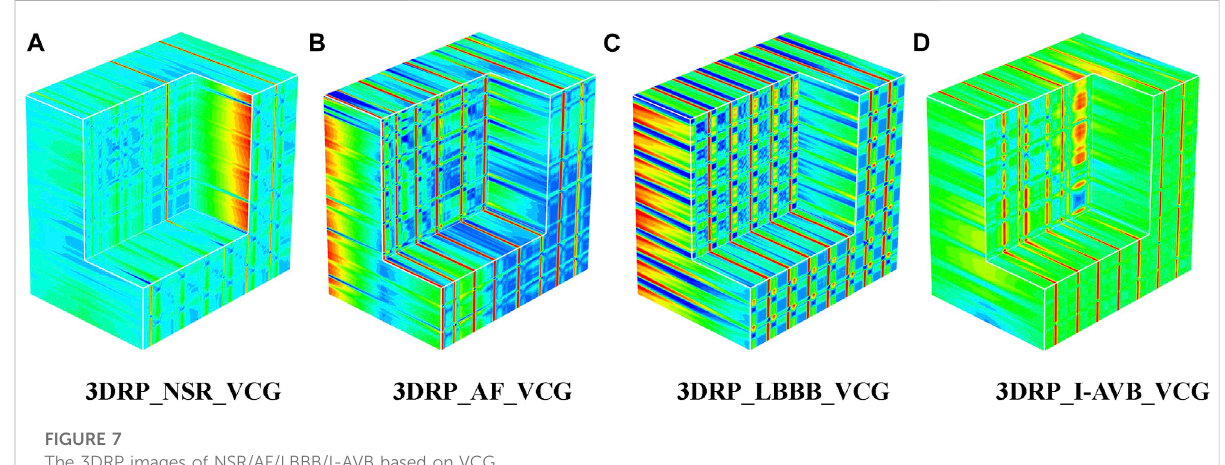
FIGURE 7 The 3DRP images of NSR/AF/LBBB/I-AVB based on VCG.